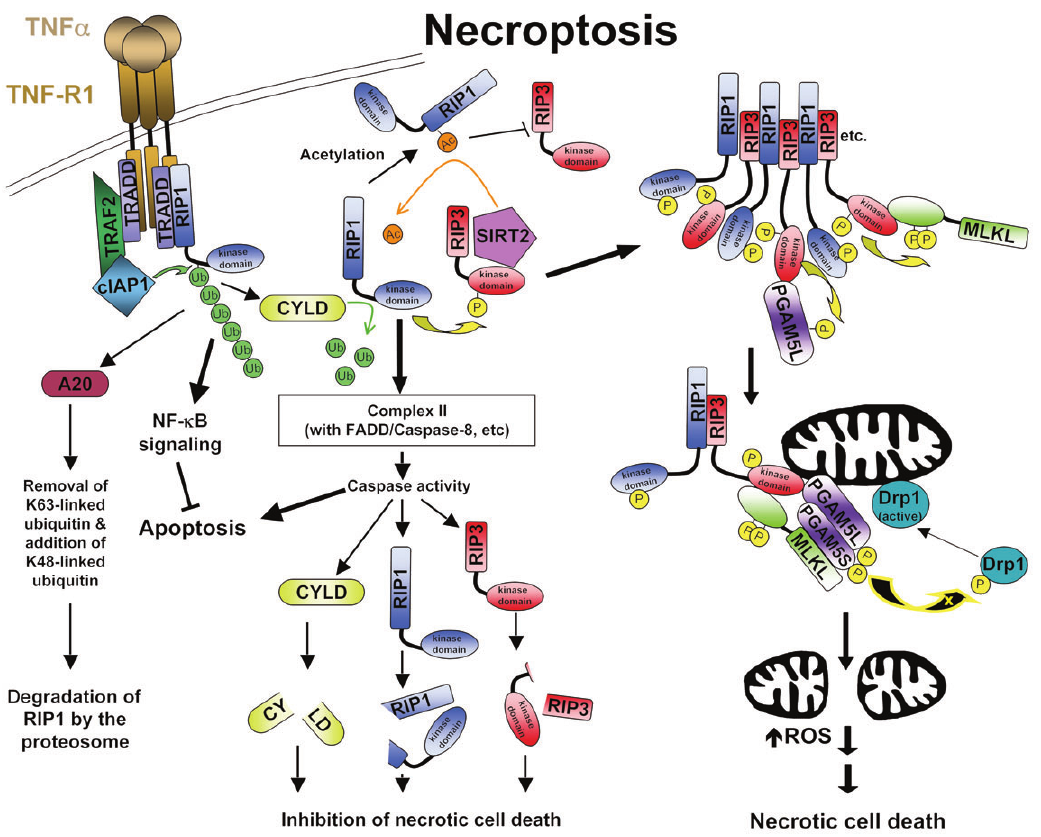
Figure 1 Necroptosis, a specific example of programmed